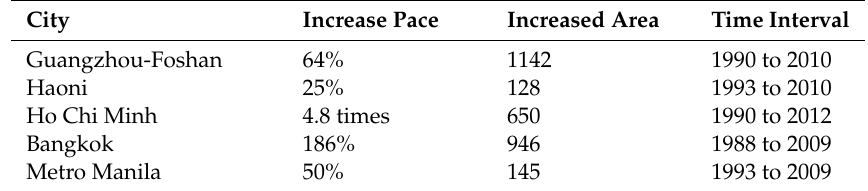
Table 1. Built-up area increases in metropolitan regions surrounding the South China Sea. City Increase Pace Increased Area Time